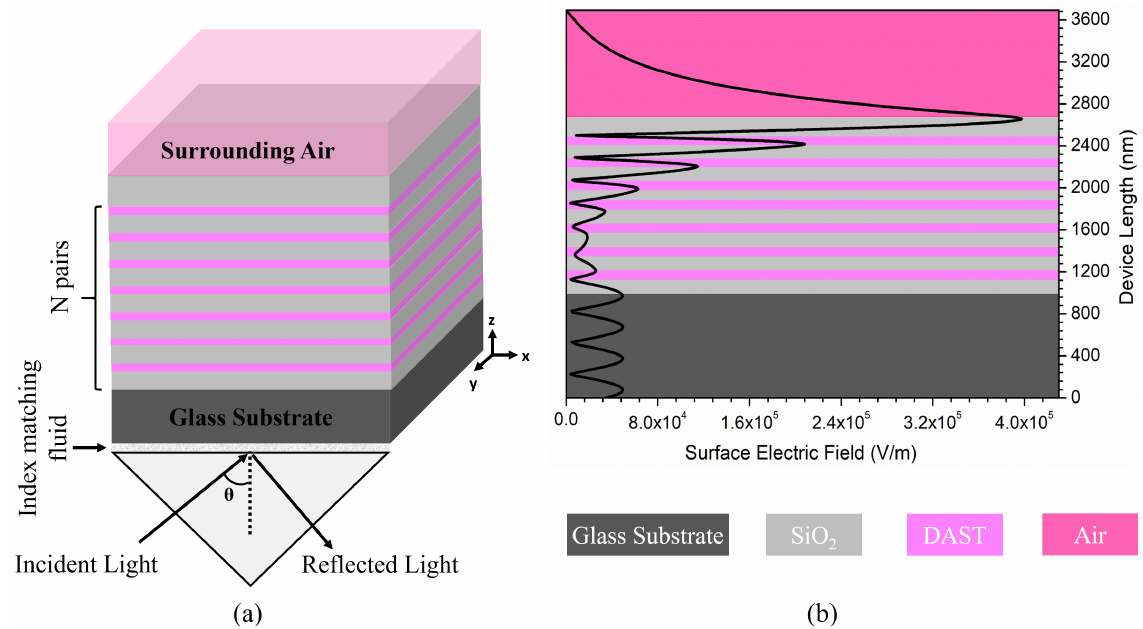
Figure 1. ( a ) Schematic of proposed filter structure and ( b ) corresponding surface electric field profile at a central wavelength of 632.8 nm and incident angle of 45.07 ◦